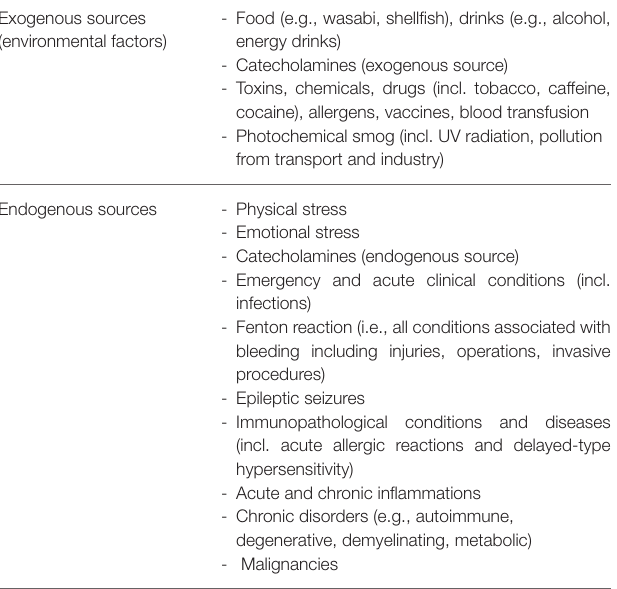
TABLE 1 | Sources of oxidative stress in acute attack of Takotsubo syndrome. Exogenous sources (environmental